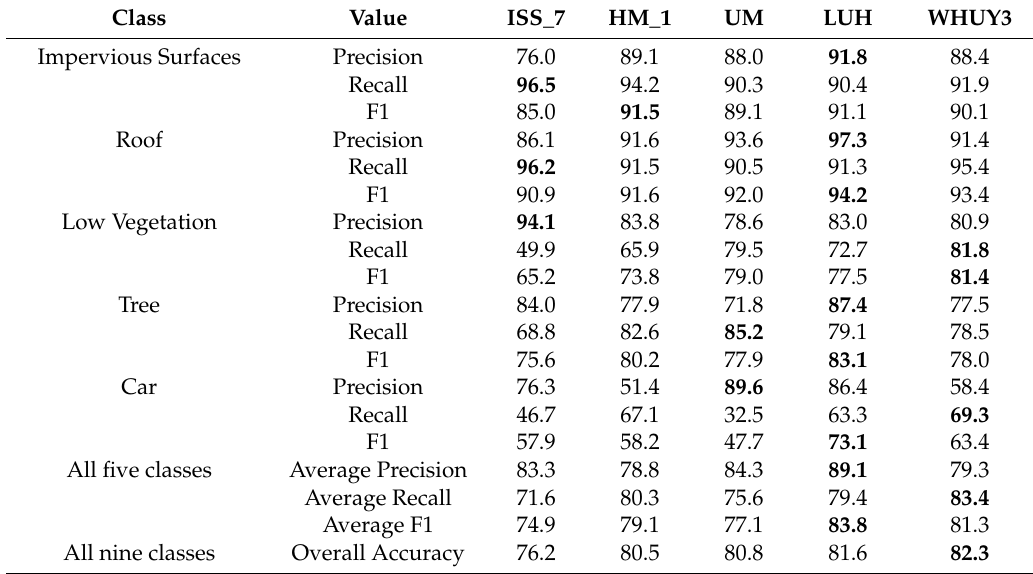
set. Bold numbers show the highest values within different